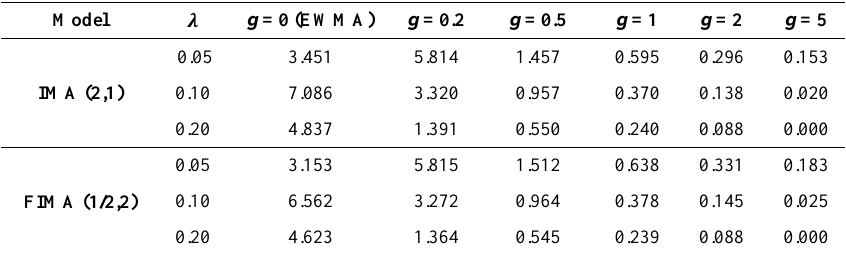
Table 4. Compare the RMI of two models at various g